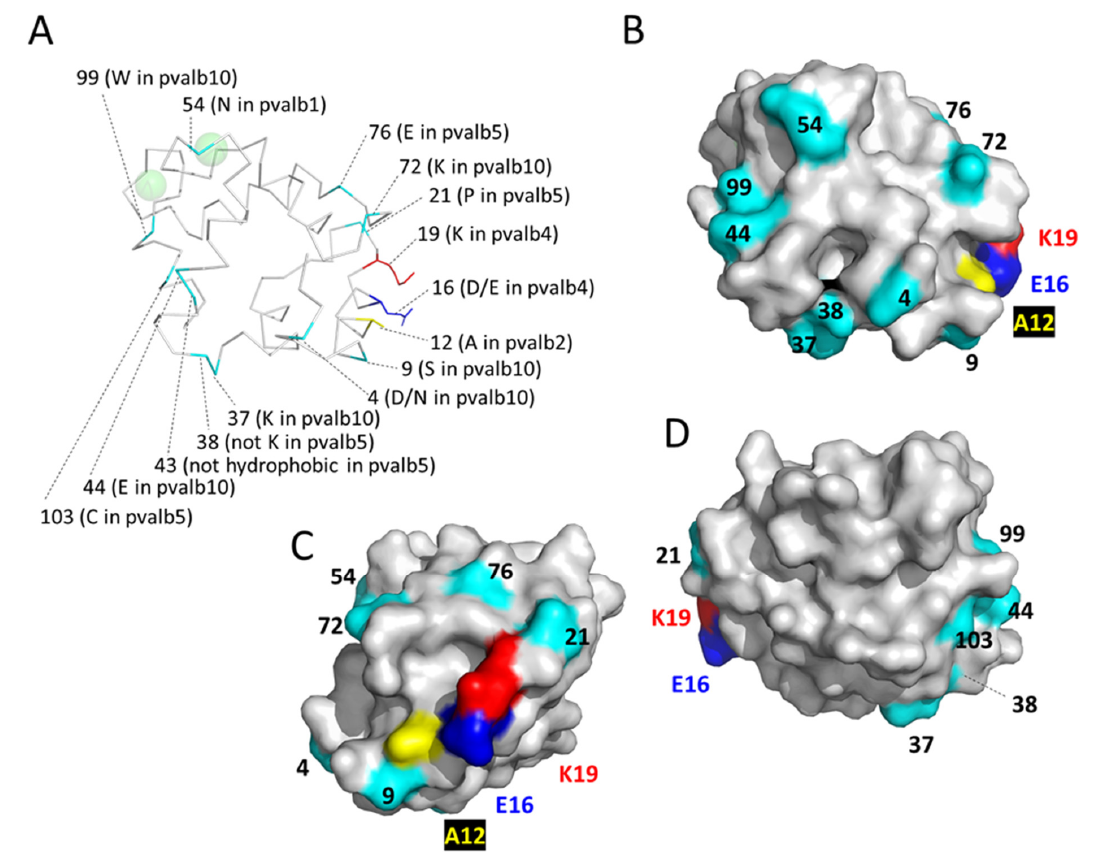
Figure 10. Structural locations of residues characteristic of individual non- α /non-oncomodulin teleost parvalbumins. The structure of common carp pvalb4_(Chr.A3) (4CPV) is shown is ribbon format ( A ) and in surface format from different angles ( B – D ), with the colors yellow, blue, and red for characteristic residues that are present in the depicted pvalb4 molecule and cyan for the other highlighted residues. In ( A ), sidechains are only shown for the pvalb4 characteristic residues E16 and K19 and the pvalb2 characteristic residue A12 (which is also present in the depicted pvalb4 molecule). The listed characteristics are for the teleost molecules (residue 9 in pvalb10 of the non-teleost fishes gar and bichir is not a serine; see Supplementary File